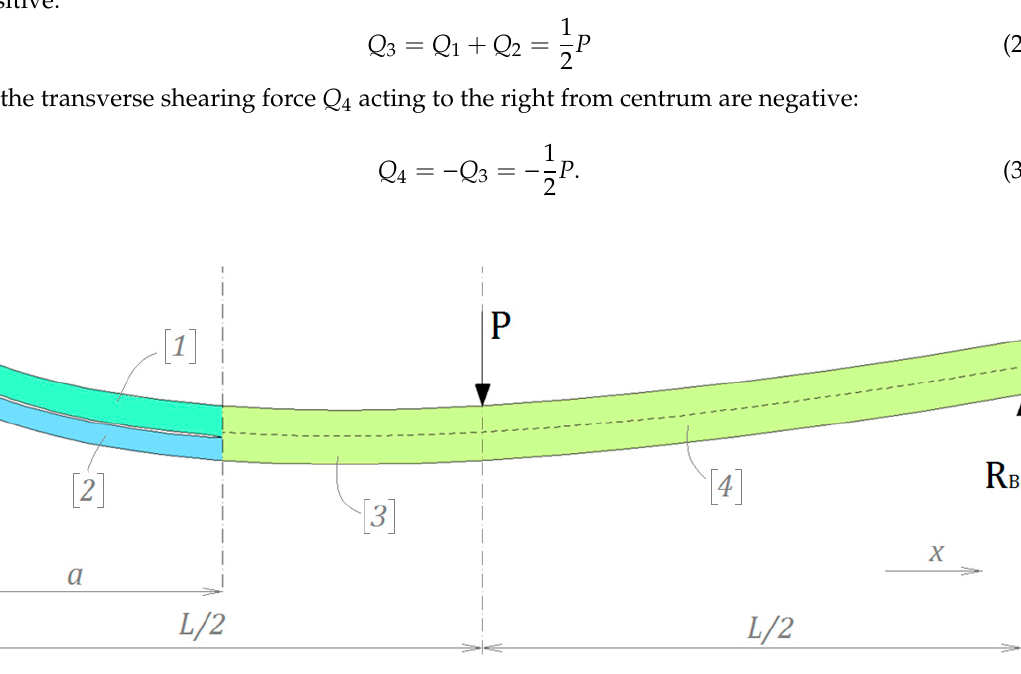
Figure 1. Theoretical division of the asymmetrical end-notched flexure (AENF) specimen.